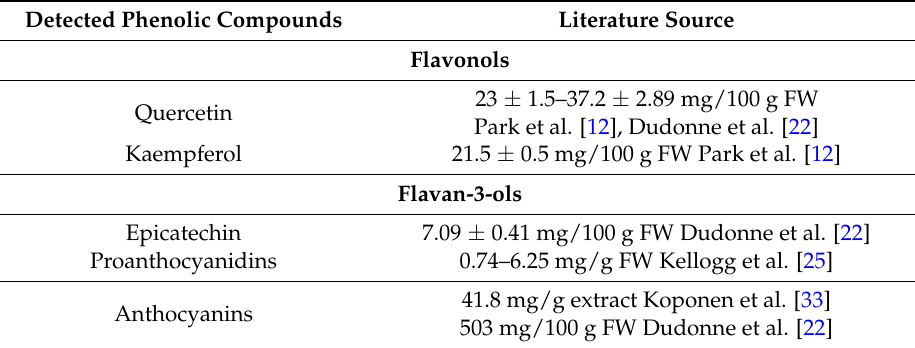
Table 1. Overview of main black crowberry ( Empetrum nigrum ) flavonoids (total